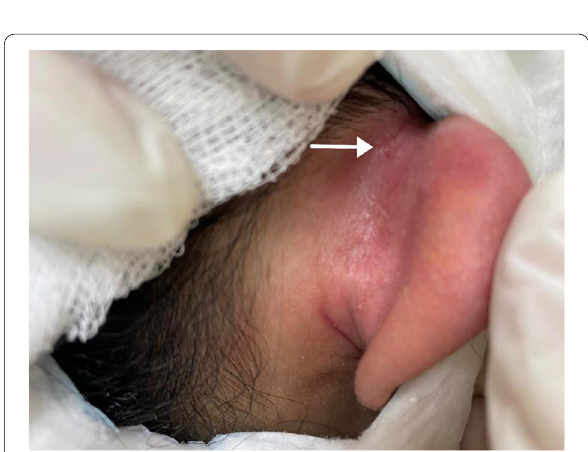
Fig. 6 Postoperative photo taken 15 months post-surgical excision of the cyst demonstrating no evidence of recurrence. The white arrow points to the surgical